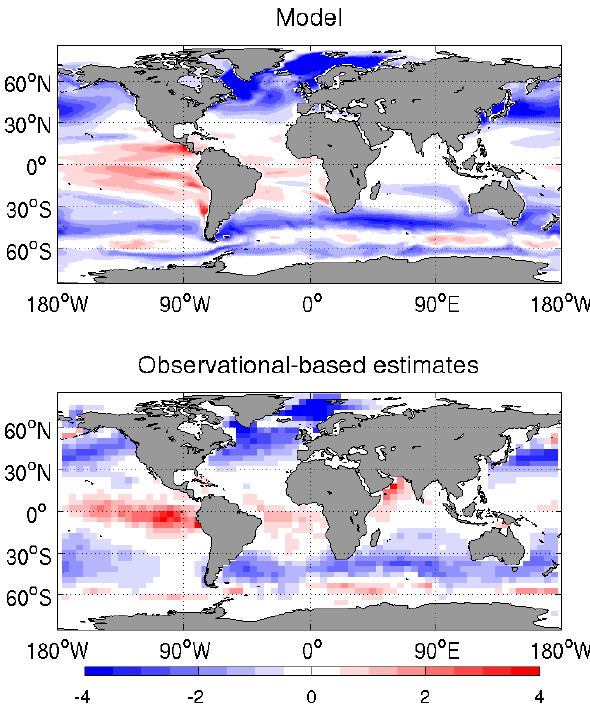
Fig. 13. Maps of annual mean sea–air CO 2 fluxes for the 1996– 2005 period simulated by the model (top) as compared to the obser- vational based estimates (bottom) of Takahashi et al. (2009). Units are in (molCm − 2 yr − 1